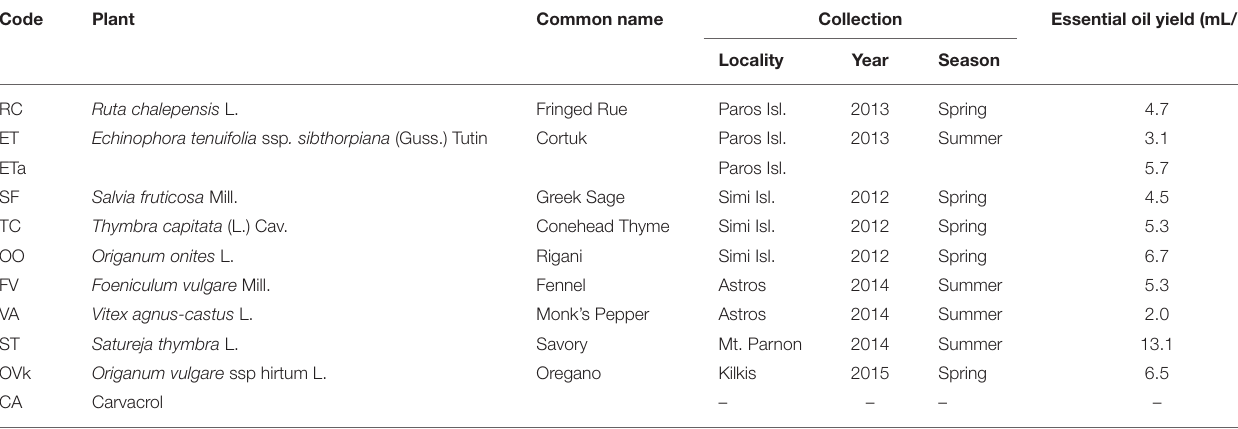
TABLE 1 | Bio prospected taxa; collection location and dates; and essential Oil yield of the herbal material.